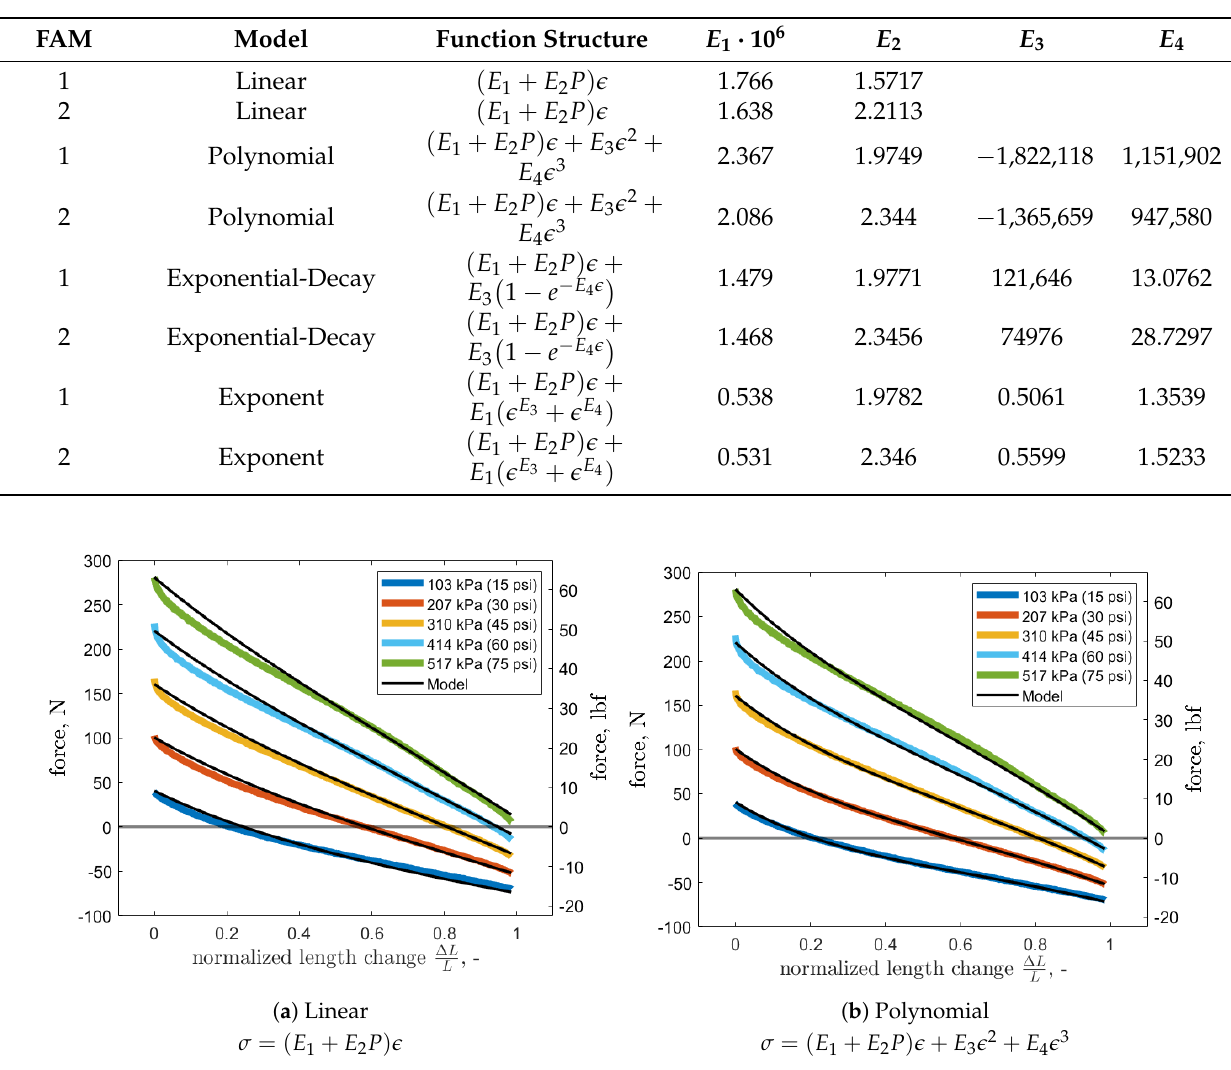
Table 4. Coefficients found through error minimization for the studied stress models.